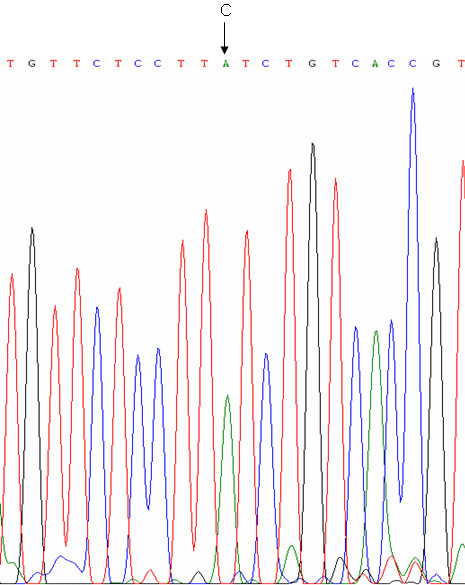
Chromatograph of ABCG2 gene indicating A → C (Y581S) mutation in Exon14.